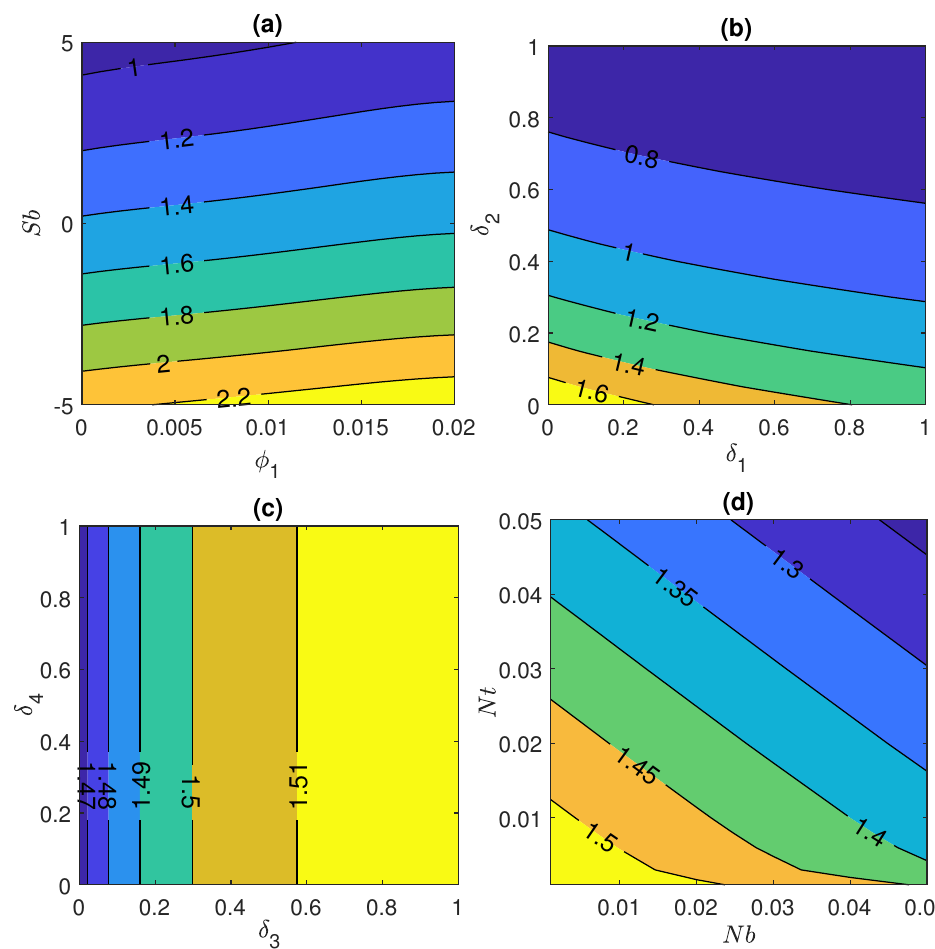
Figure 8. Nusselt number for ( a ) Stefan blowing Sb and initial volume fraction φ 1 , ( b ) velocity slip parameter δ 1 and thermal slip parameter δ 2 , ( c ) volume fraction slip parameter δ 3 and motile concentration slip δ 4 and ( d ) Brownian motion Nb and thermophoresis Nt